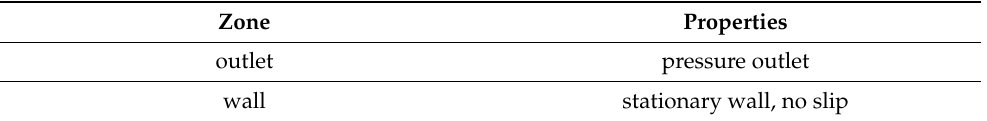
Table 4. Boundary